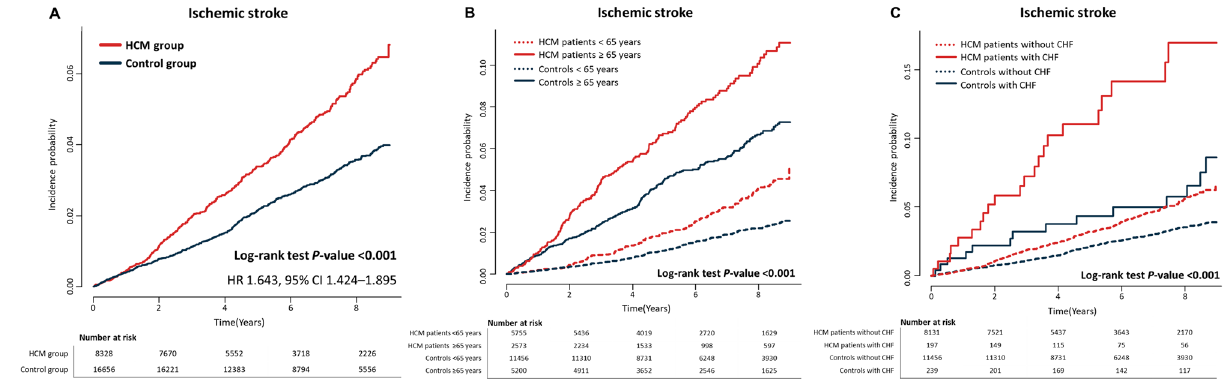
Figure 2. Kaplan–Meier curve showing incident ischemic stroke. ( A ) Kaplan–Meier curve for incident ischemic stroke in the hypertrophic cardiomyopathy (HCM) and control groups. Kaplan–Meier curves for incident ischemic stroke stratified by ( B ) age (< 65 and ≥ 65 years) and ( C ) the presence or absence of chronic heart failure (CHF). Neither group had documented atrial fibrillation nor a previous history of thromboembolic events, anticoagulation use, or